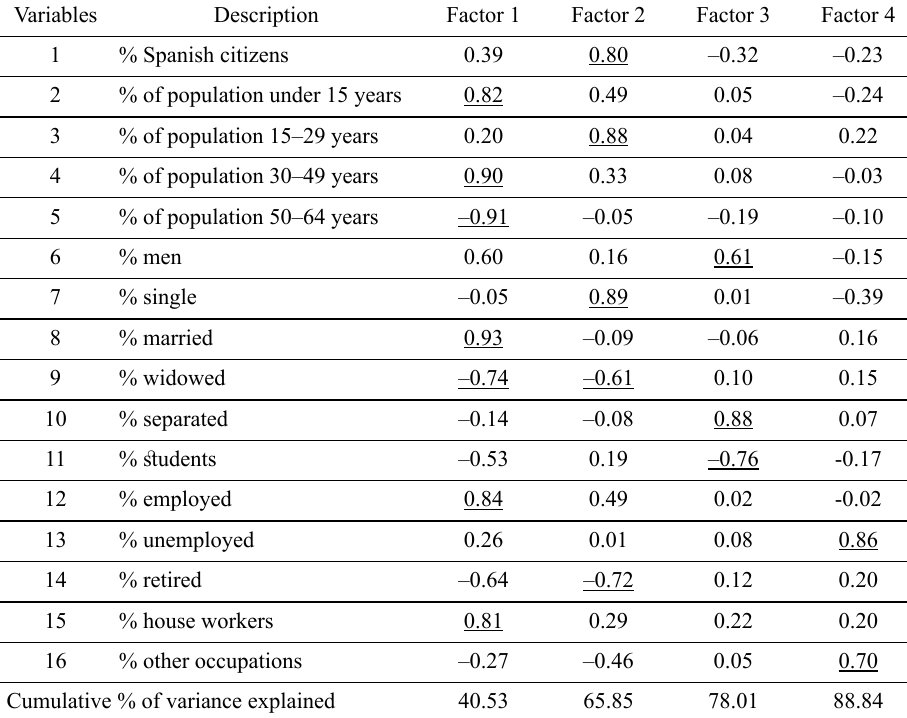
Table A.1. Principal component analysis of sociodemographic variables